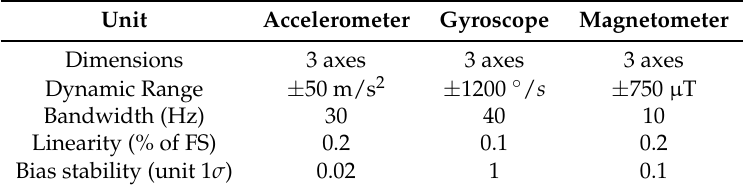
Table 1. Sensor performance